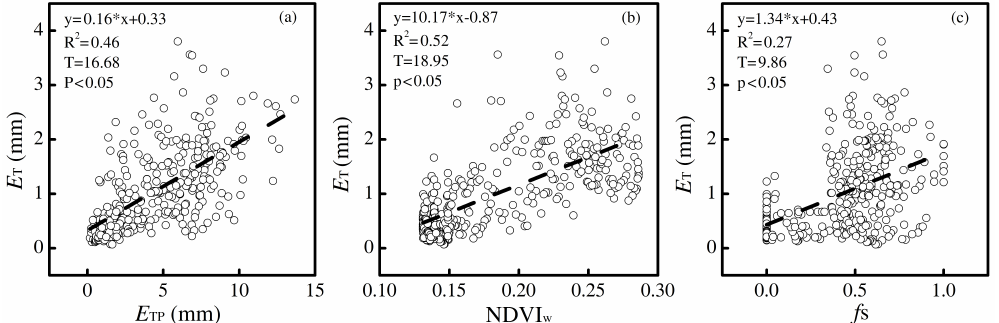
Figure 6. The correlations between daily evapotranspiration ( E T , mm) and its controlling factors: (a) daily potential evapotranspiration ( E TP , mm); (b) daily weight-averaged NDVI (NDVI w ) within the footprint; and (c) daily soil water stress of the root zone ( f s ) in Period I by excluding the data on rainy days ( r : Pearson’s correlation coefficient; T : t test